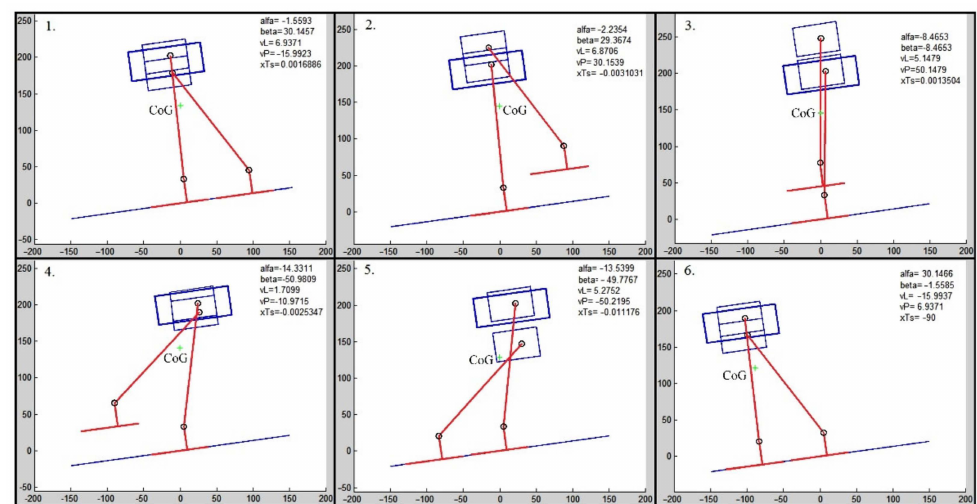
Figure 9. Plotted configurations of the robot when walking on a pad with a slope of –8 ◦ . Legends: 1—the center of gravity of the robot is above the right foot; 2—the left linear actuator performs the upward stroke of the left foot; 3—the left ankle joint rotates to move the left foot forward and at the same time the right ankle joint balances the robot’s pose to the vertical position of the legs; the right linear actuator also works to keep the base at a constant height; 4—the left ankle joint transmits the left foot forward and at the same time the left linear actuator lowers the foot; the right linear actuator also lifts the base to keep it at a constant height. 5—the left foot is lowered to the ground; 6—both ankle joints rotate so that the center of gravity is transferred above the left foot and at the same time the height position of the base is compensated by the movement of both linear